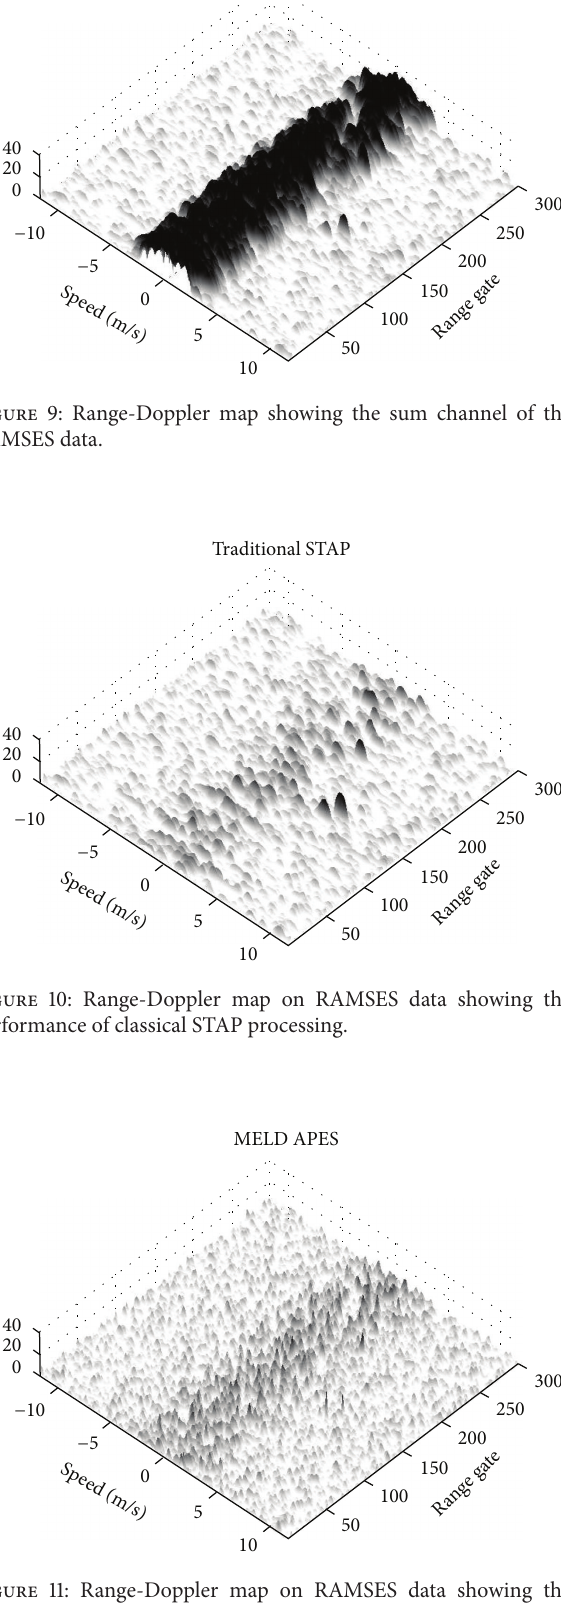
Figure 11: Range-Doppler map on RAMSES data showing the performance of the MLED detector.